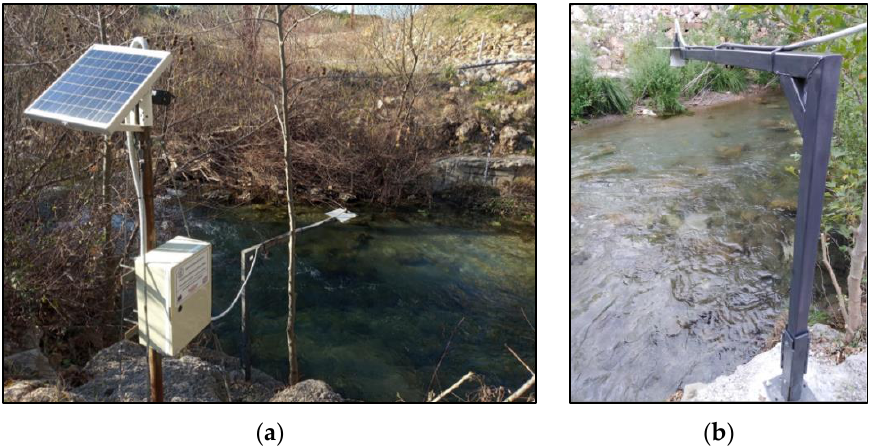
Figure 3. HTM Evrotas station: ( a ) installation on the right bank of the river looking downstream, and ( b ) close-up photo of the sensor assembly.